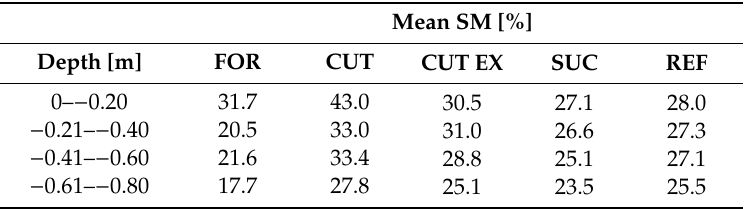
Table 5. Mean soil moisture (SM). Depth aggregated